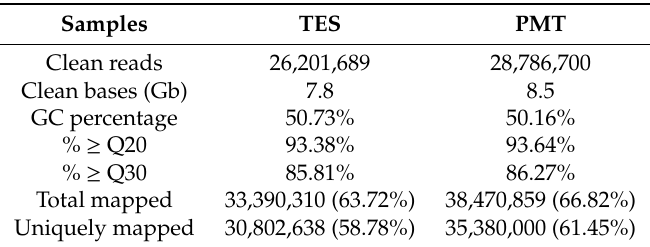
Table 3. Summary of L. crocea transcriptome data.